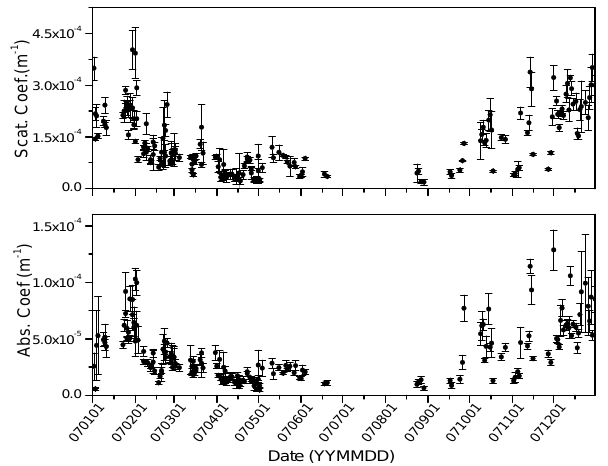
Fig. 1. Temporal variation of scattering coefficients (top panel) and absorption coefficients (bottom panel) at 550nm obtained from in situ